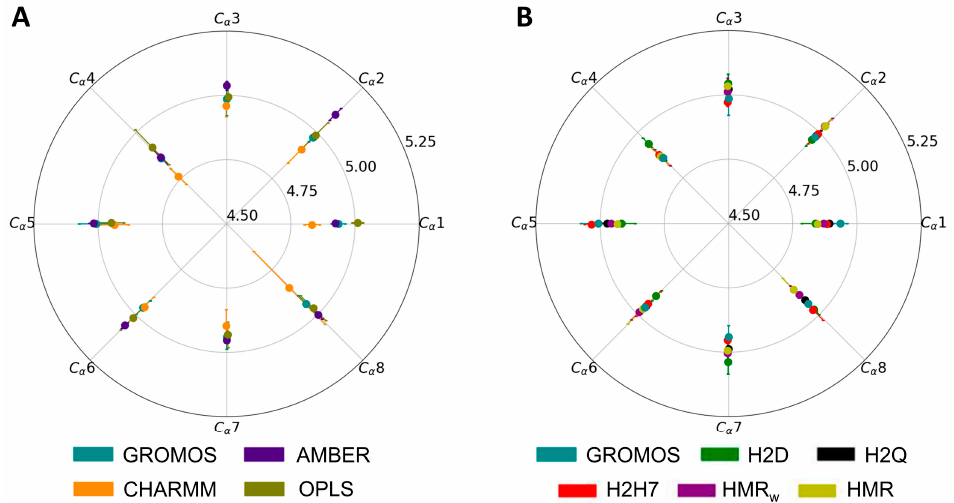
Figure 3. Average radial and angular contributions to the deformation of CP4 determined as ex- plained in the Materials and Methods section, over the last 220 ns of each trajectory. The average radial distance and angle with respect to the geometrical center of the CP (in Å) are indicated in the corresponding circles. Each radial line in the circular bar plot represents the angle expected from an octagonal disposition of each C α in the CP, while the position of the different solid circles represents the angular deviation with respect to it. The results for each force field are indicated by a different color (see legends). The results for unmodified GROMOS are reproduced in both circular bar plots ( A , B ) as a reference. Results for the rest of the CPs are shown in Figure